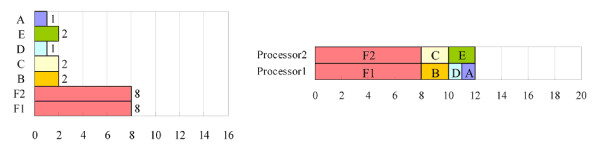
The result of dividing long tasks into short tasks in the processing order list. Task F in Figure 5 is divided into two tasks with identical processing times, yielding the new task list. The overall processing time for a two-processor computer is 12 units, which equals the optimal processing time.